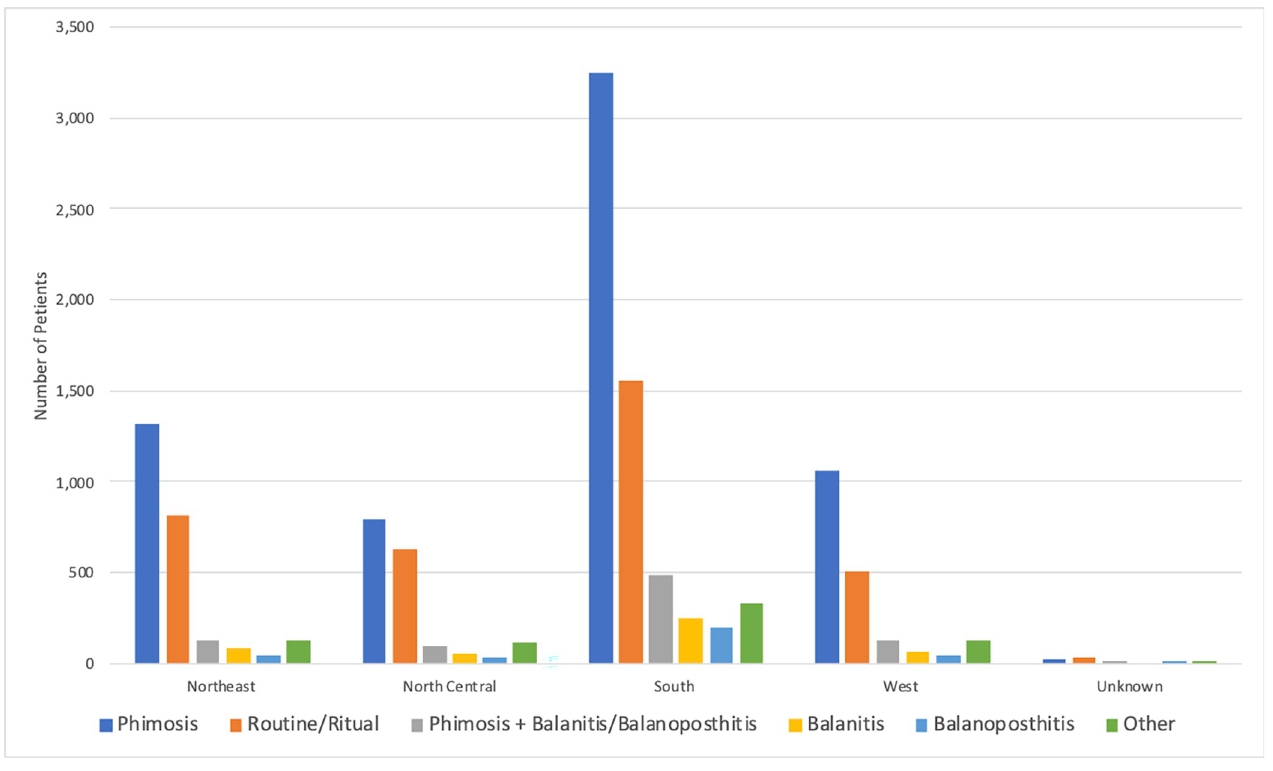
Fig 2. Indications for adult circumcision stratified by the United States regions ( p < 0.01).